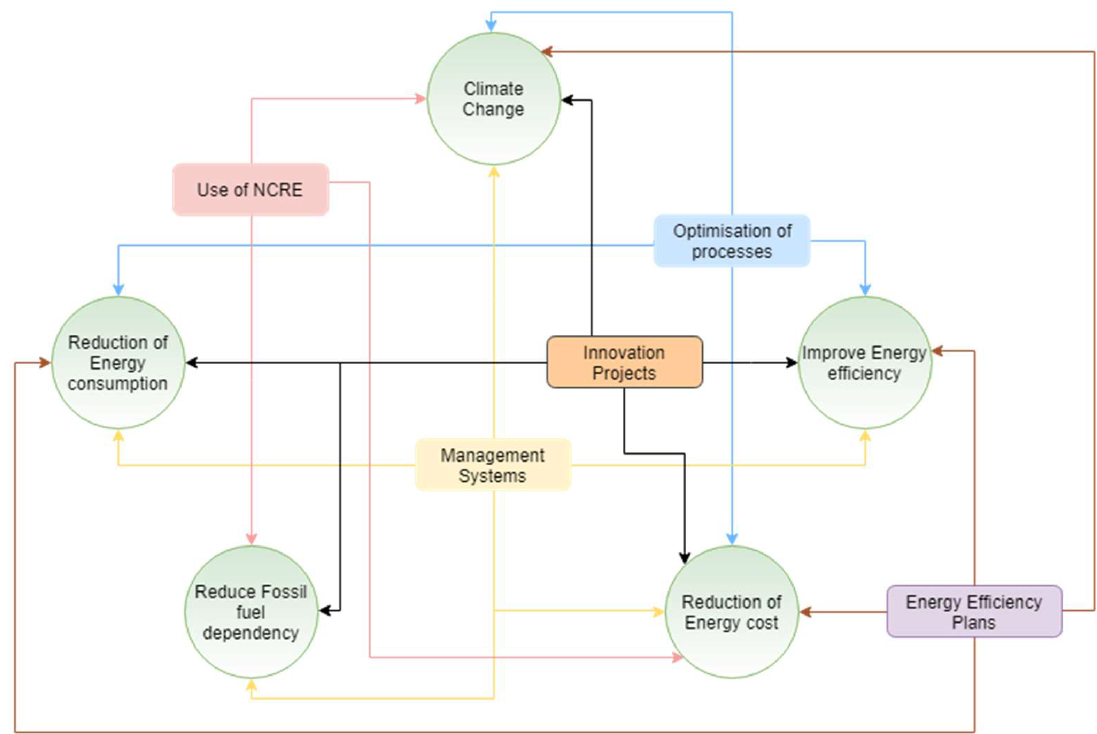
Figure 4. The relationship between energy challenges and dominant initiatives used by mining companies in Chile.